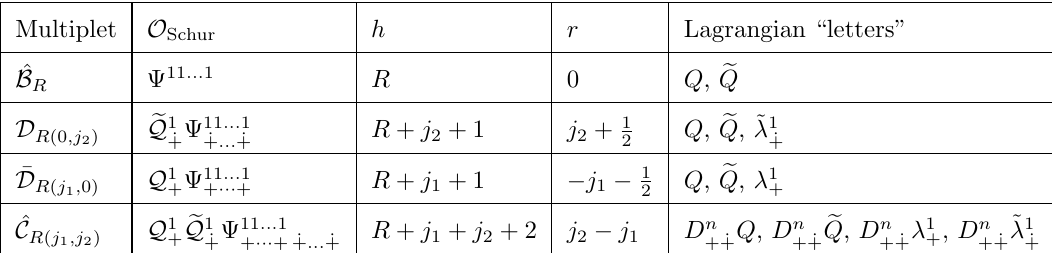
Table 1 . Summary of the appearance of Schur operators in short multiplets of the = 2 supercon- N formal algebra, su (2 , 2 2). The superconformal primary in a supermultiplet is denoted by Ψ. There | is a single conformal primary Schur operator in each listed superconformal multiplet. The O Schur holomorphic dimension h and U(1) r charge r of are given in terms of the quantum numbers O Schur ( R, j 1 , j 2 ) that label the shortened multiplet (left-most column). The schematic form that O Schur can take in a Lagrangian theory is also indicated in terms of the elementary “letters” from which the operator may be built. The complex scalar fields in a hypermultiplet are denoted by Q and Q , while the left- and right-handed fermions in a vector multiplet are denoted by λ I and ˜ λ I . Gauge α ˙ α e covariant derivatives are denoted by D α ˙ α